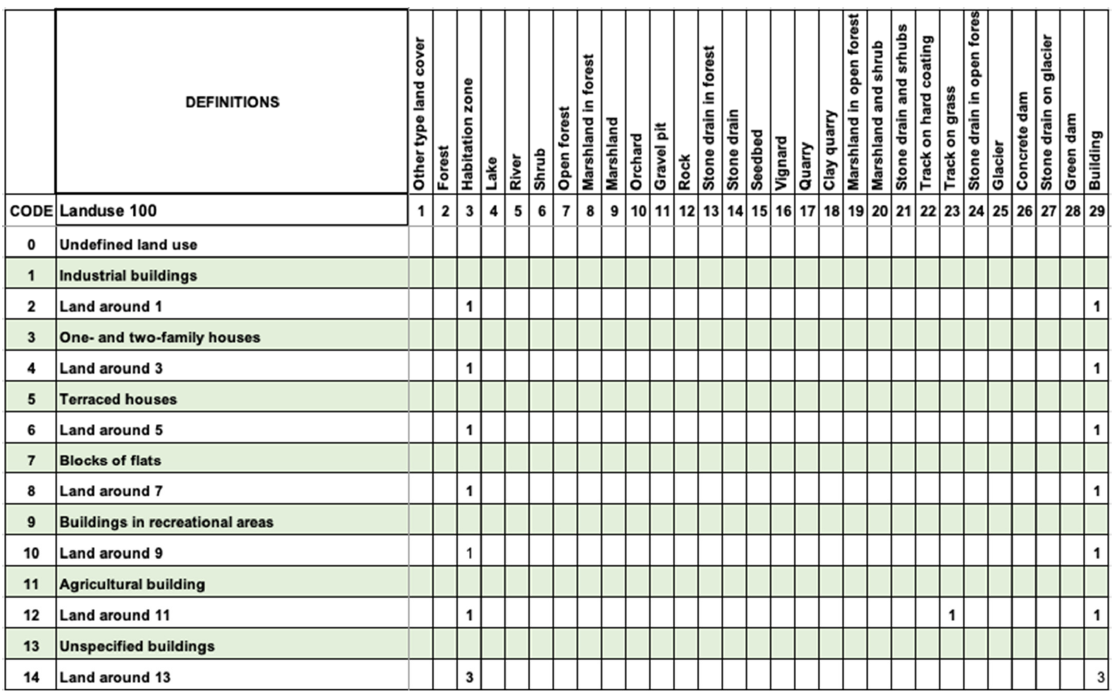
Figure 4. Expert system showing the possible authorized Landuse100 categories within BaseMap25 units; (1) represents possible choices, (2) unique choice, and (3) the default choice in case of lack of decision. Ten land use categories remain unmatched (shaded). Three categories correspond to punc- tual or linear features (dark grey), and seven categories (light grey) correspond to different types of buildings that were merged with their surroundings (green). A full version of the expert table is available in the Supplementary Material Table S1. The main steps of the downscaling methodology are the following (data preparation: